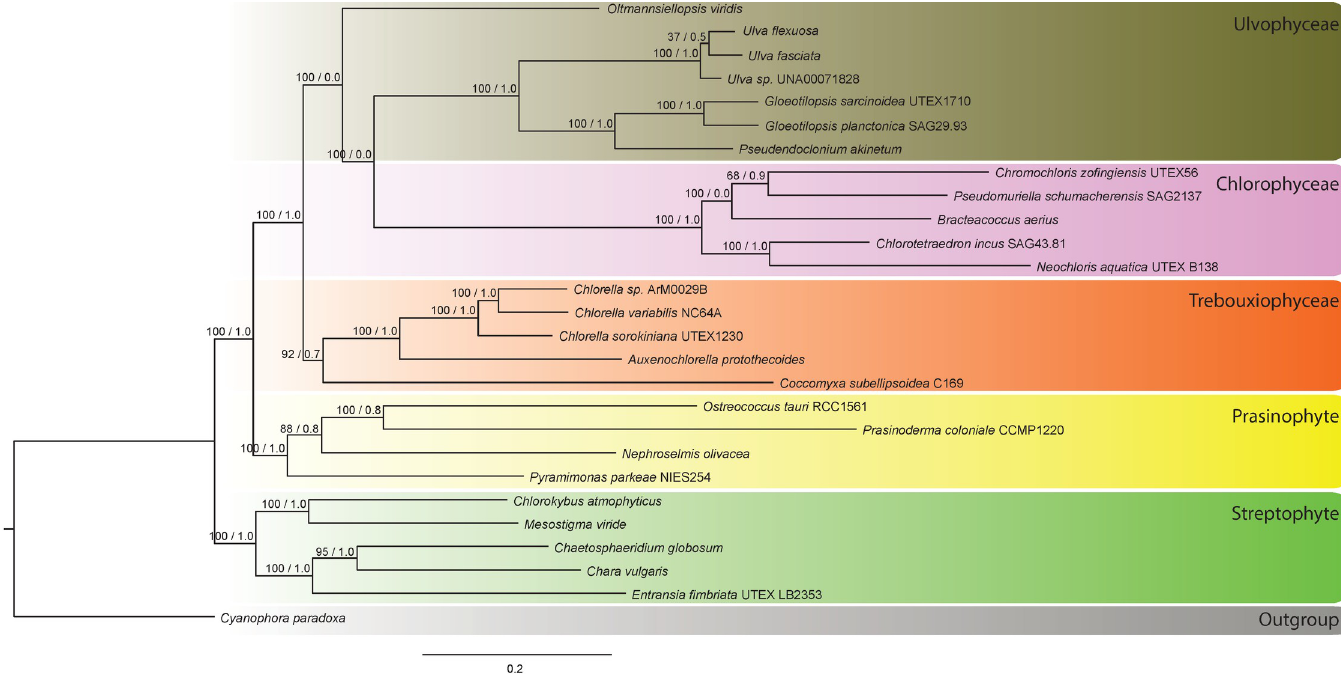
Fig 1. Maximum-Likelihood tree inferred from 58 protein-coding sequences– 13 mitochondrial and 45 plastid genes. Bootstrap value from ML and posterior probability from Bayesian inference are shown at the node. The scale bar represents the estimated number of nucleotide substitution per site.